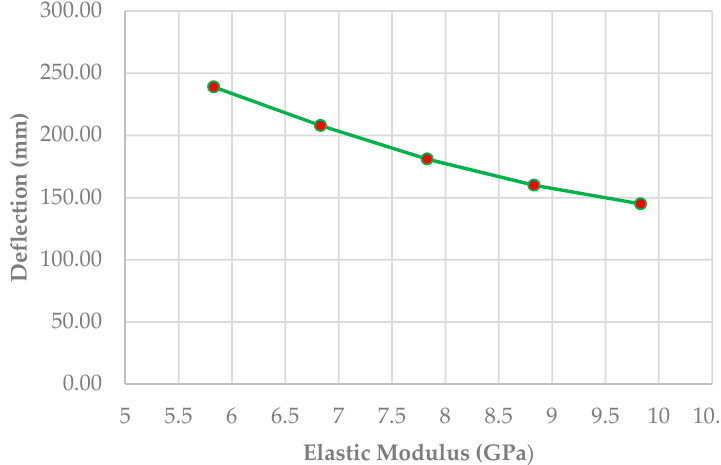
Figure 15. Relationship between elastic modulus and deflection of the FFU composite beam models under bending load.